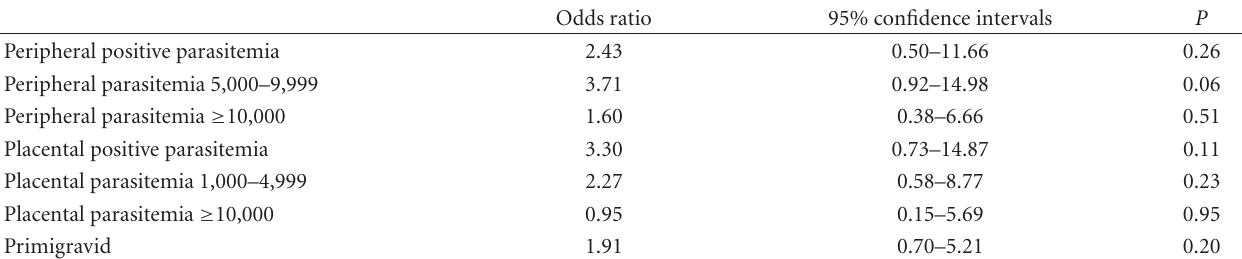
Table 4: Multivariate logistic regression of risk factors, associated with Plasmodium falciparum parasitemia in umbilical cord blood. Odds